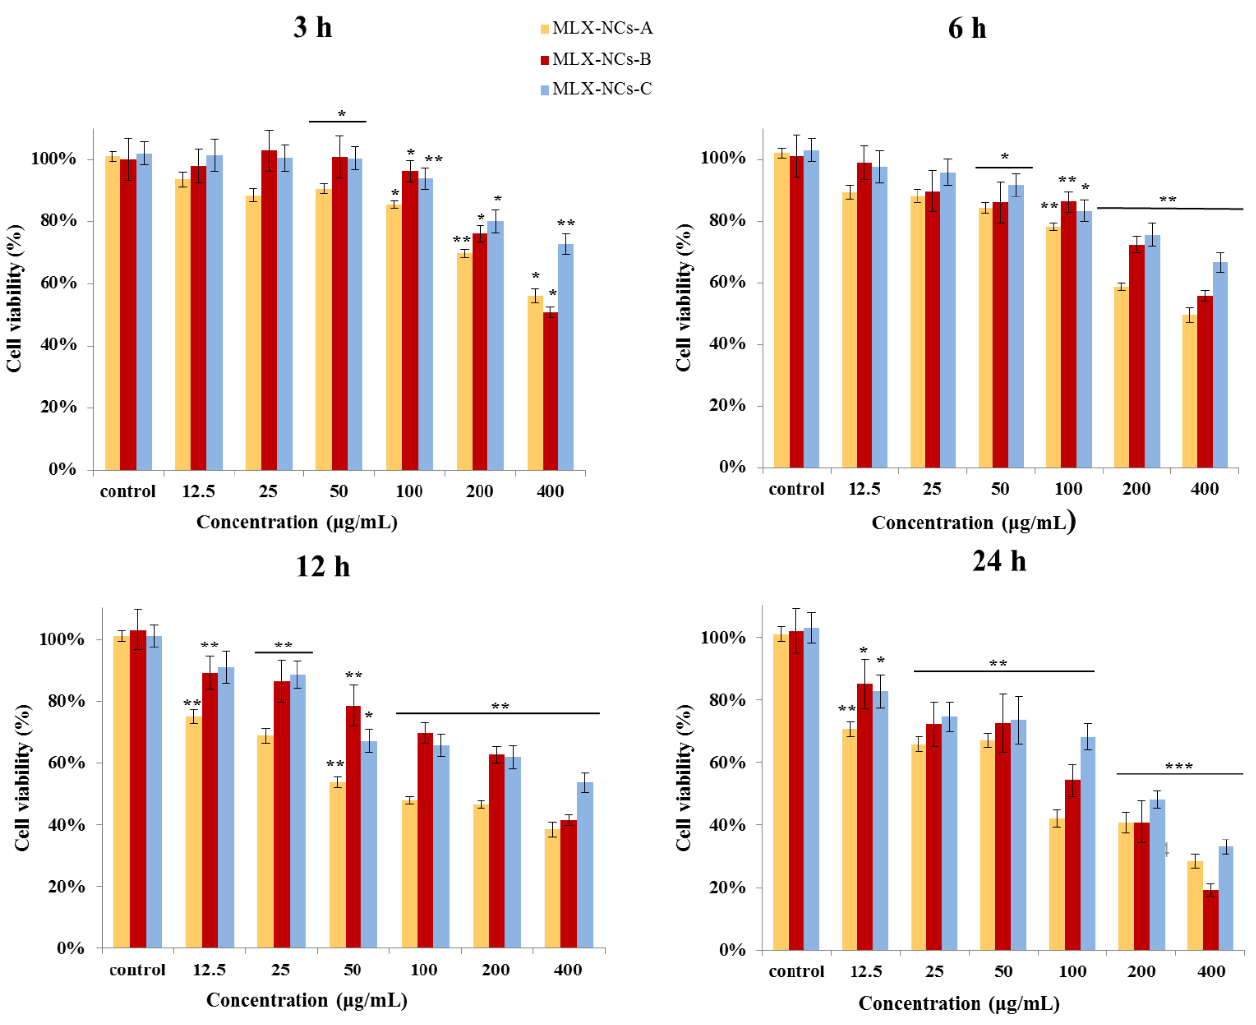
Figure 9. Cell cytotoxicity following MLX-NCs-A, MLX-NCs-B, and MLX-NCs-C treatments for the Caco-2 cell (mean ± SD., n = 6,* p < 0.05, ** p < 0.01, *** p < 0.001 in comparison to the untreated control).